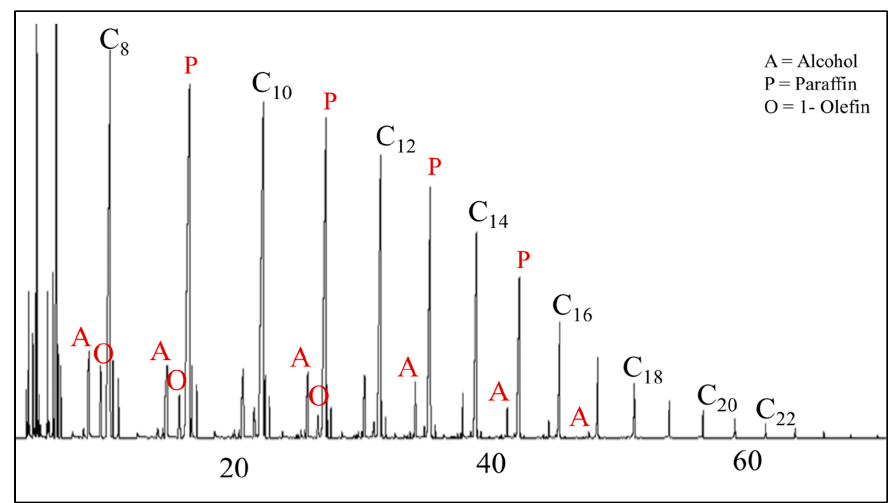
Figure 32. A chromatographic picture of a carbon supported cobalt catalyst. The x-axis is retention time in minutes. Reaction conditions: 230 °C, 27.6 bar, WHSV = 0.5, and H 2 /CO = 2.